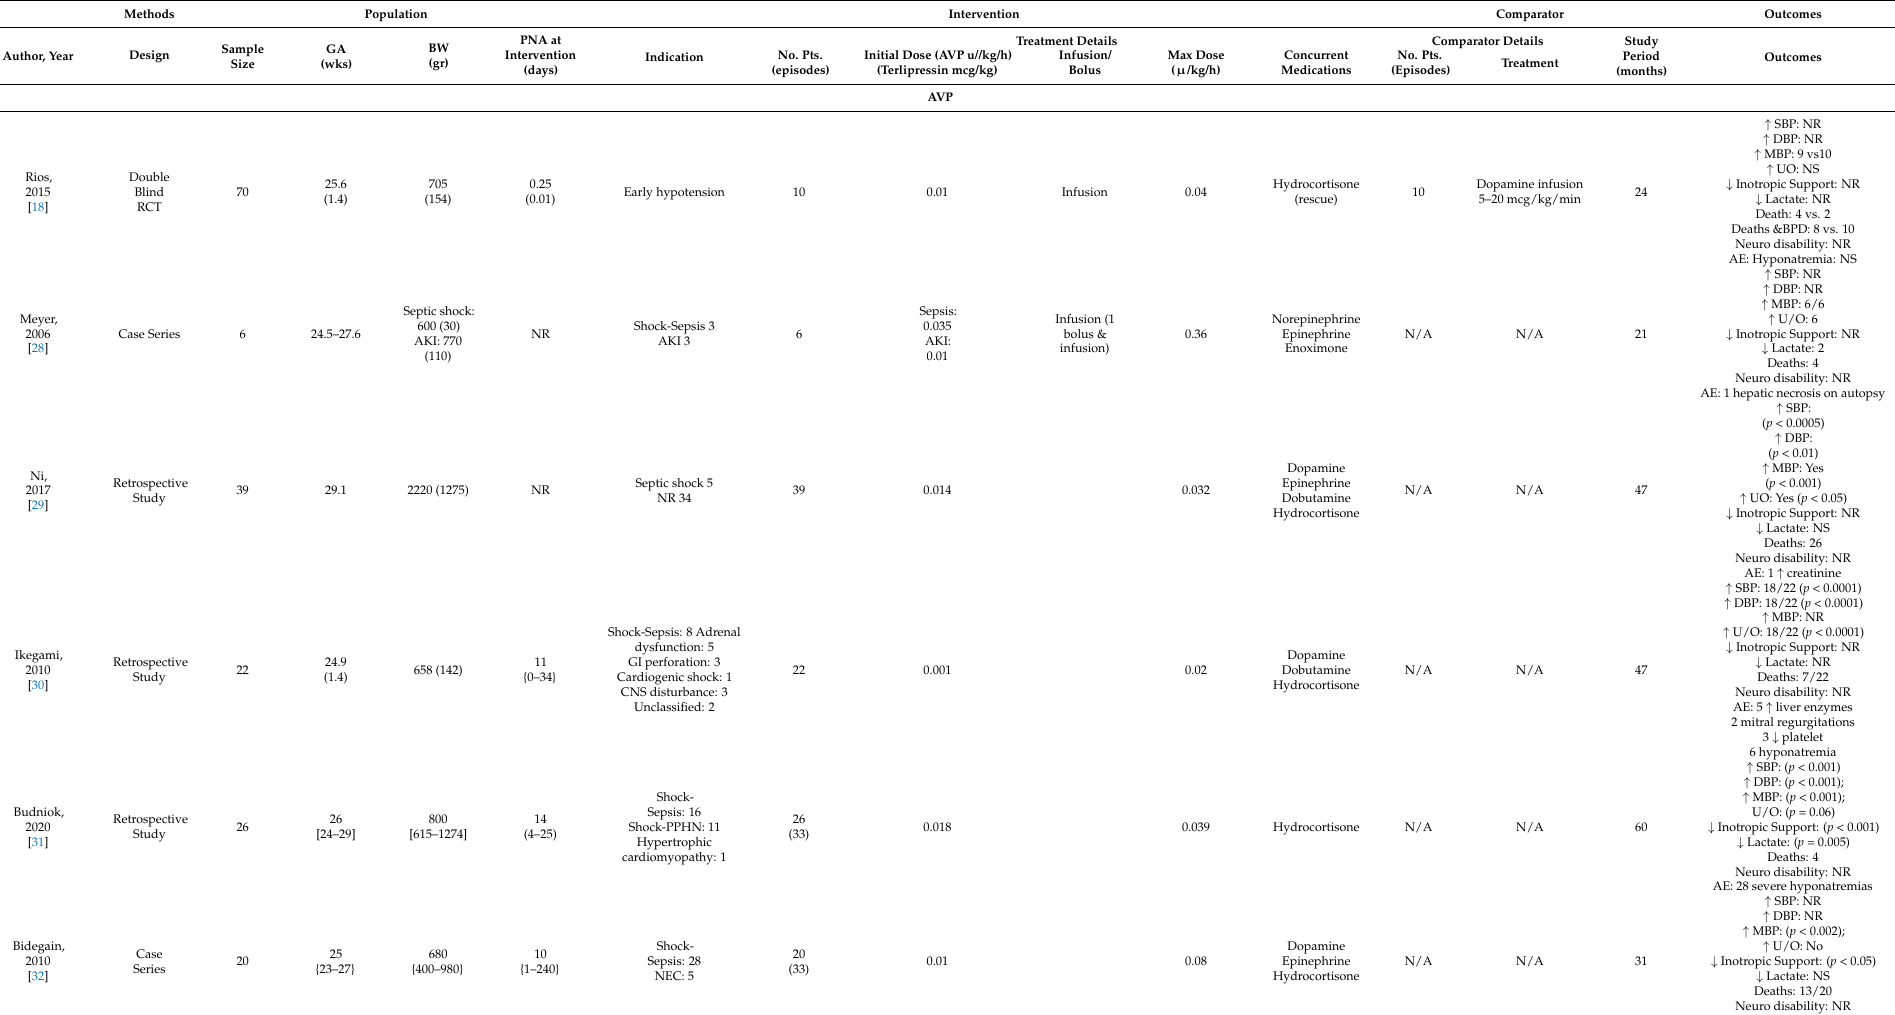
Table 1. Characteristics of included studies on arginine vasopressin (AVP) and terlipressin on hypotension and persistent pulmonary